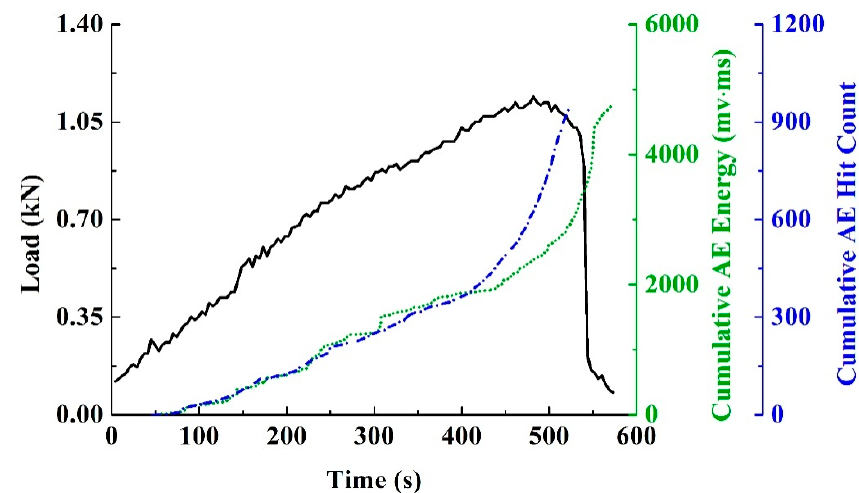
Figure 12. The cumulative AE energy and cumulative AE hit count of the water–oil-saturated sample (W-O-1).